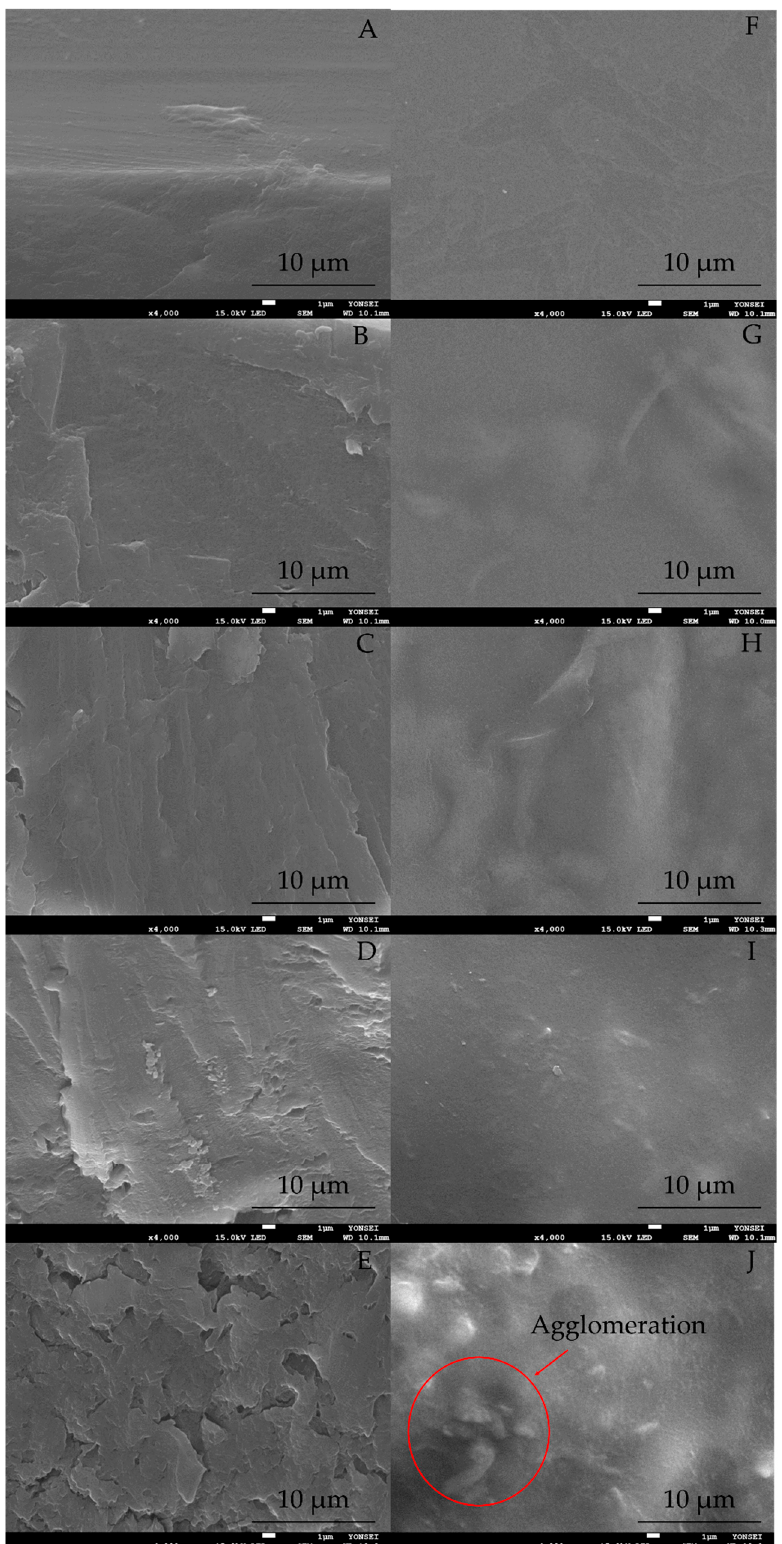
Figure 1. Field emission scanning electron microscopy images of the cross-section of the pure hydroxypropyl methylcellulose (HPMC) ( A ), 5% microcrystalline cellulose (MCC) (H5MB) ( B ), 10% MCC (H10MB) ( C ), 20% MCC (H20MB) ( D ), and 30% MCC (H30MB) ( E ) films and the surface of the HPMC ( F ), H5MB ( G ), H10MB ( H ), H20MB ( I ), and H30MB ( J ) films.